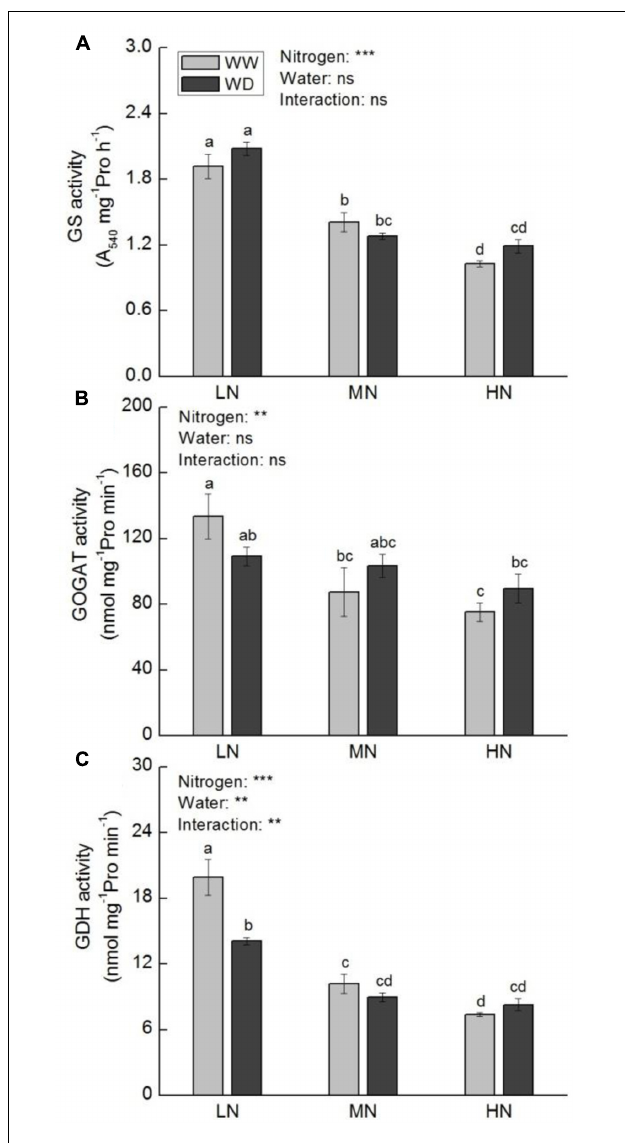
FIGURE 7 | Comparison in activities of glutamine synthase (GS, A ), NADH-glutamate synthase (NADH-GOGAT, B ), and NADH-glutamate dehydrogenase (NADH-GDH, C ) in rice plants grown under different nitrogen and water conditions. Data refers to mean ± SE ( n = 4). P -values of the two-way ANOVAs of nitrogen, water, and their interaction are indicated: ns, not significant; ∗ P < 0.05; ∗∗ P < 0.01; ∗∗∗ P < 0.001. Bars with the same letter are not significantly different by LSD test. WD, water deficit; WW,